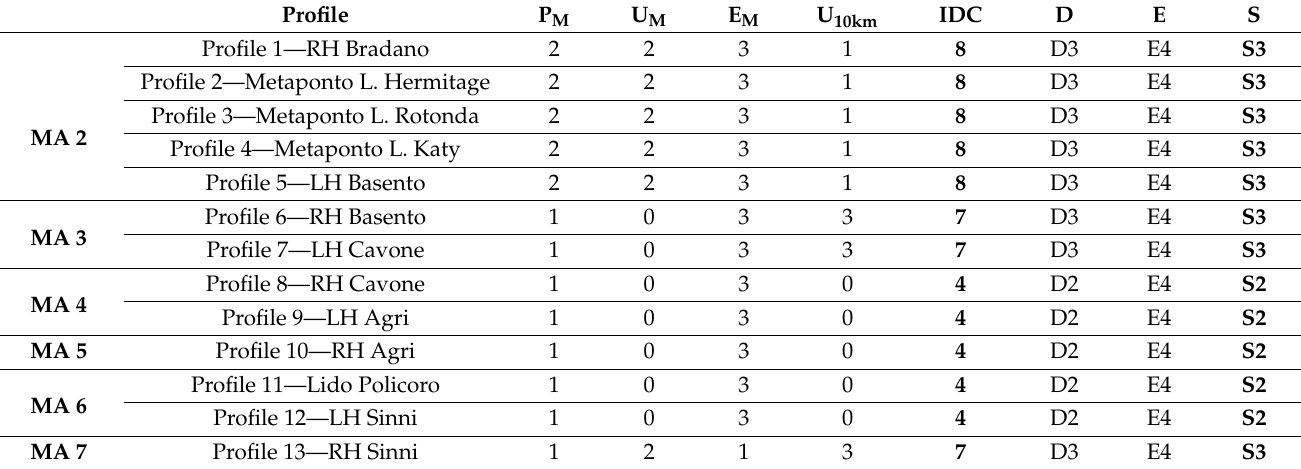
Table 8. Socio-economical vulnerability of the Ionian Basilicata coast. D = potential damage, E = exposure and S = socio-economical